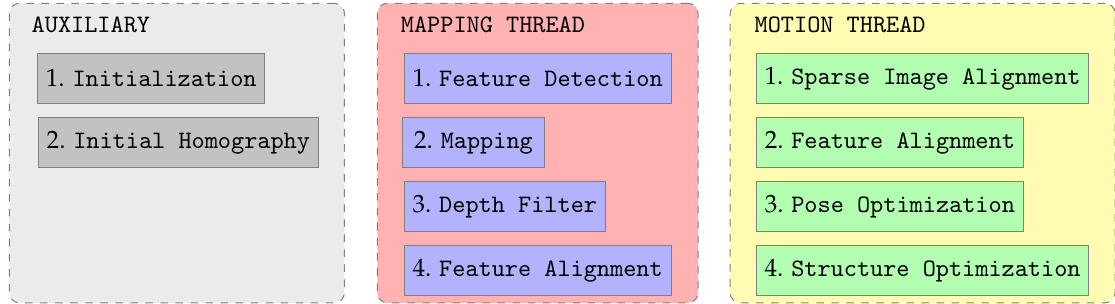
Figure A2. SVO threads and processes.